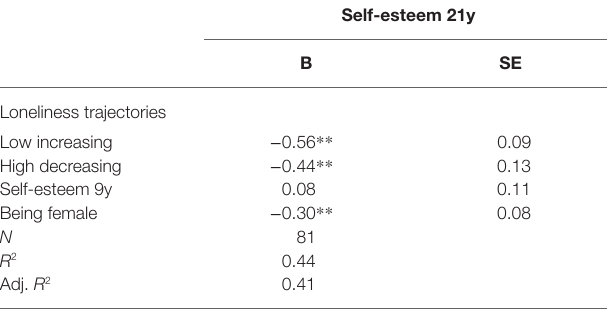
TABLE 5 | Results of the regression analysis predicting self-esteem at age